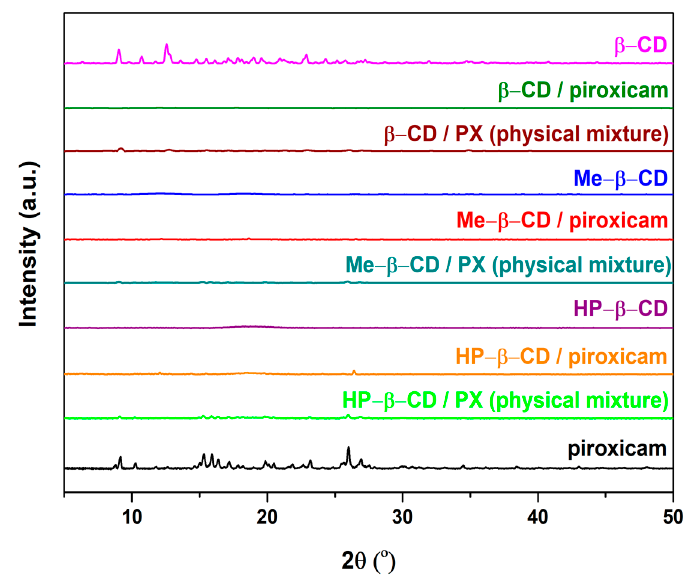
Figure 3. XRD patterns of pure compounds and binary systems.